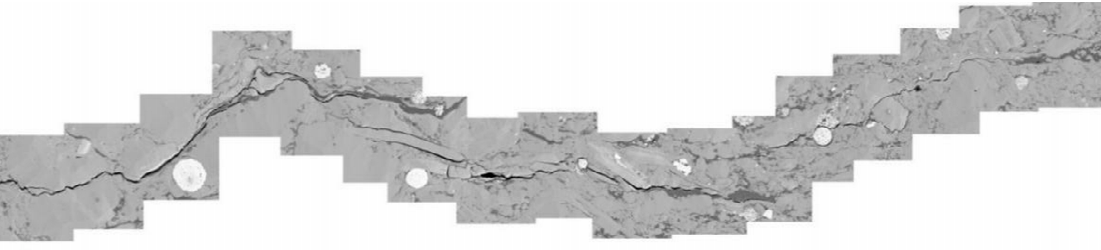
Figure 5. Spliced image (individual image size is 15 µm × 10 µm) showing microcracks.